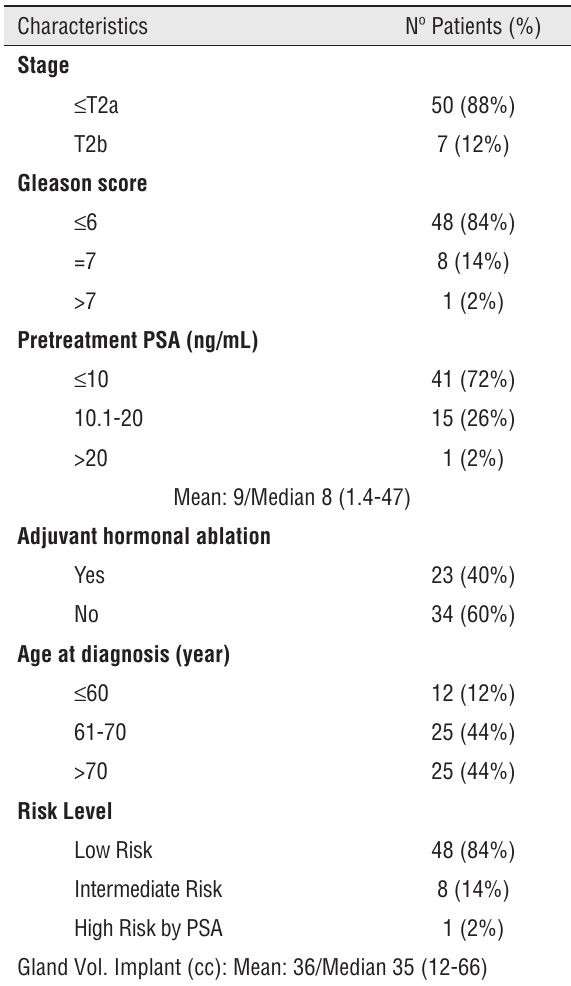
Table 1 - Patient and tumor characteristics (n=57).